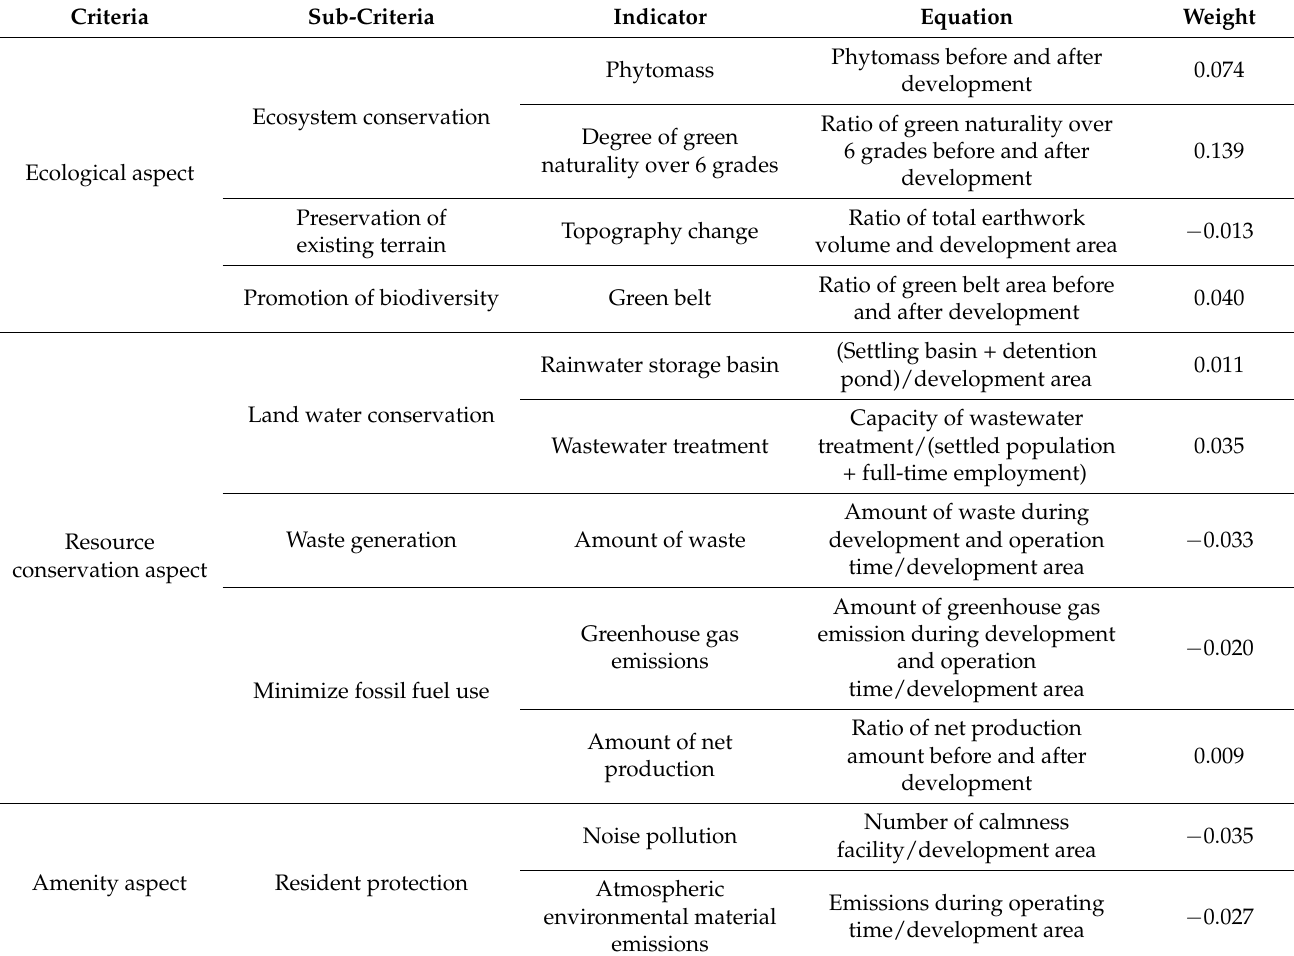
Table 1. Indicators, equations and weights for calculating traditional KEI’s environmental index for development projects (KEIDP) (translated from Korean to